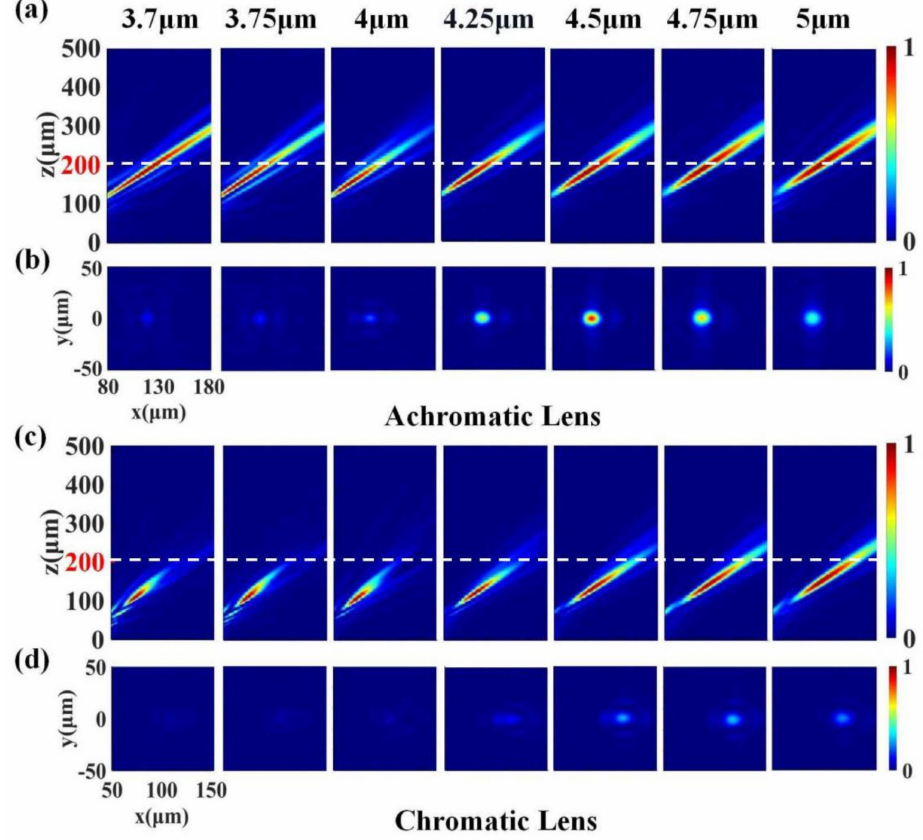
Figure 6. Simulation results within the working bandwidth of 3.7–5 µ m. The angle θ between the incident light and the optical axis is 30 ◦ . ( a ) Normalized x – z plane light intensity distributions for seven different wavelengths of the achromatic lens. ( b ) Normalized x – y plane light intensity distributions on the designed focal plane (at 200 µ m), marked with a white dashed line in ( a ). ( c ) Normalized x – z plane light intensity distributions for seven different wavelengths of the chromatic lens. ( d ) Normalized x – y plane light intensity distributions on the designed focal plane (at 200 µ m), marked with a white dashed line in ( c ). All focal points are offset from the optical axis in the x -direction to varying